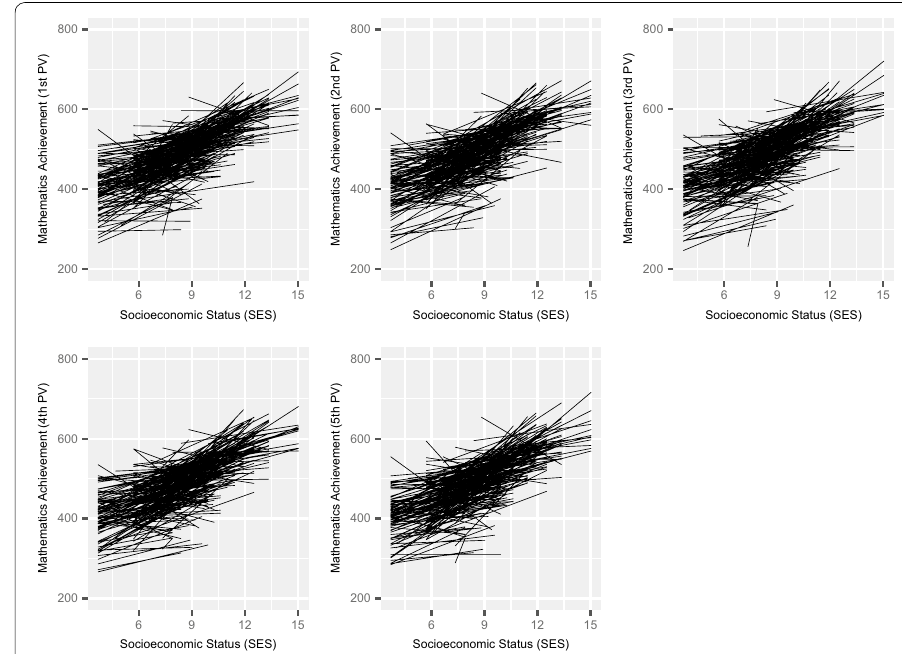
Fig. 1 Associations between SES and mathematics achievement within schools by plausible value